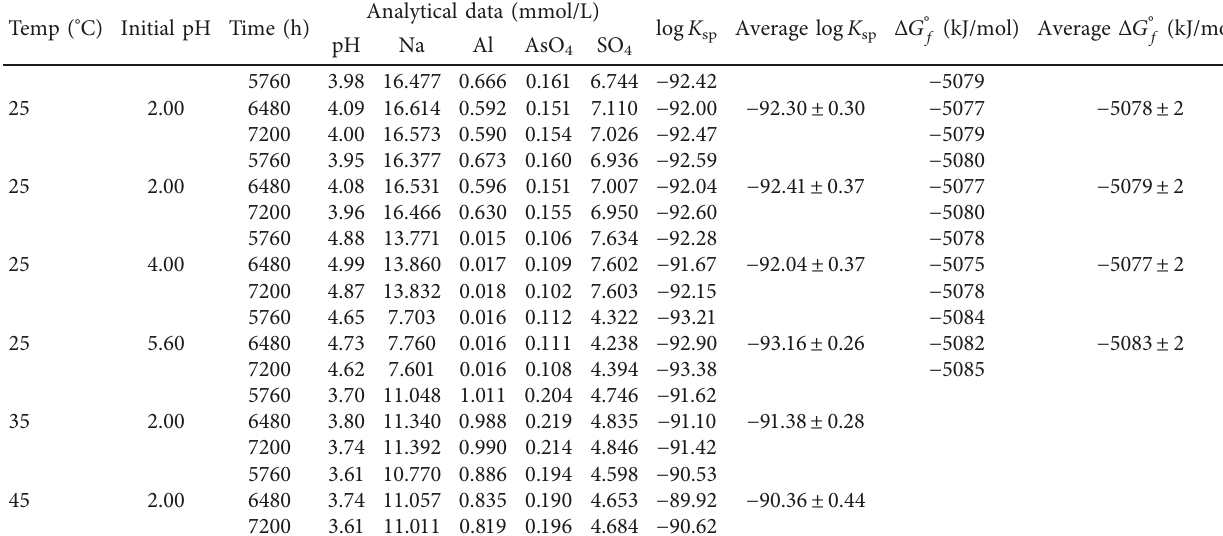
0.88 (H 3 O) 2.44 Al 2.35 (AsO 4 ) 0.38 (SO 4 ) 1.62 ](OH) 6 ].